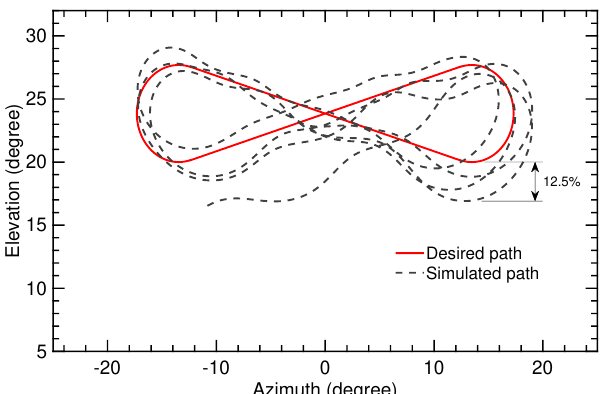
Figure 14. Trajectory computed on the basis of the SI algorithm and adaptive controller for flight time of 70 s.